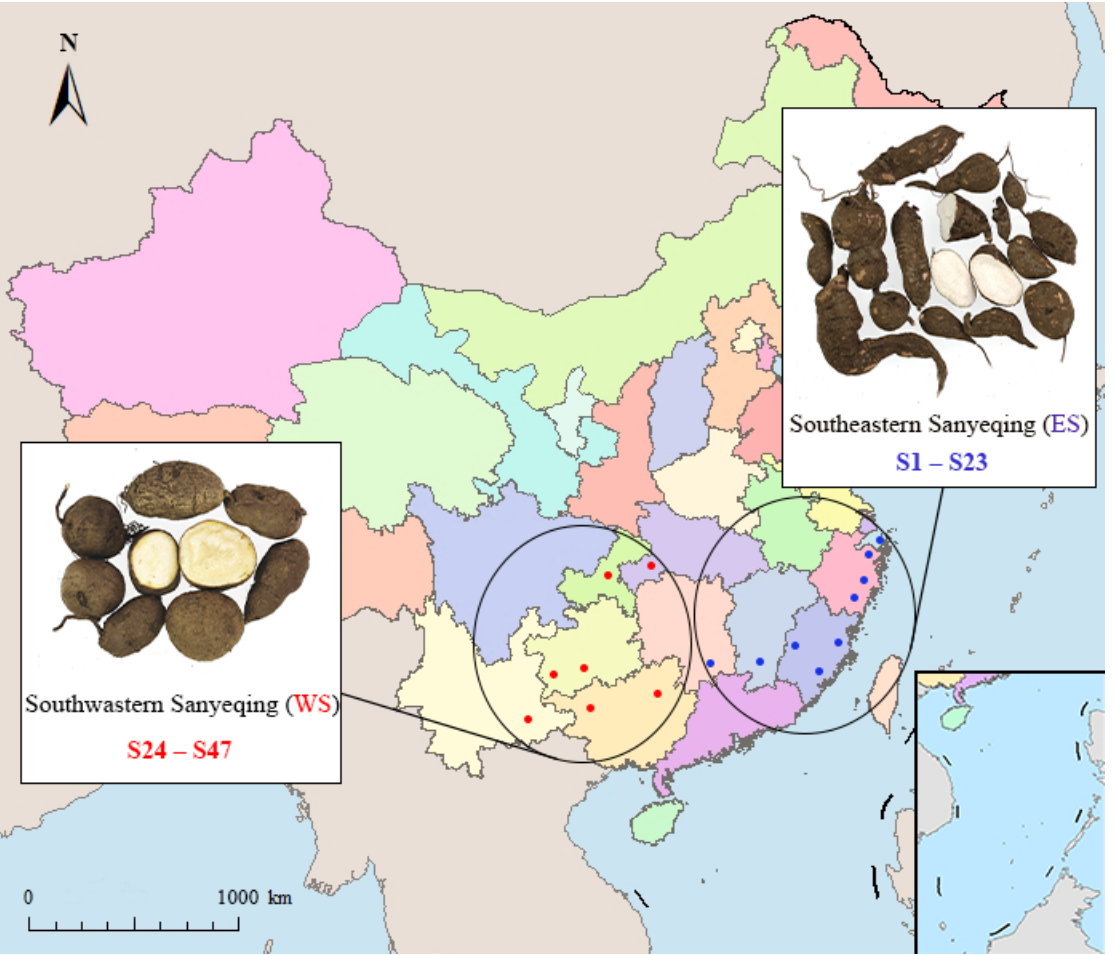
Figure 2. SYQ of two different habitats (ES, WS). The ES samples (S1–S23) were from nine origins and the WS samples (S24–S47) were from seven origins. The origin information of the samples are presented in Table 4.